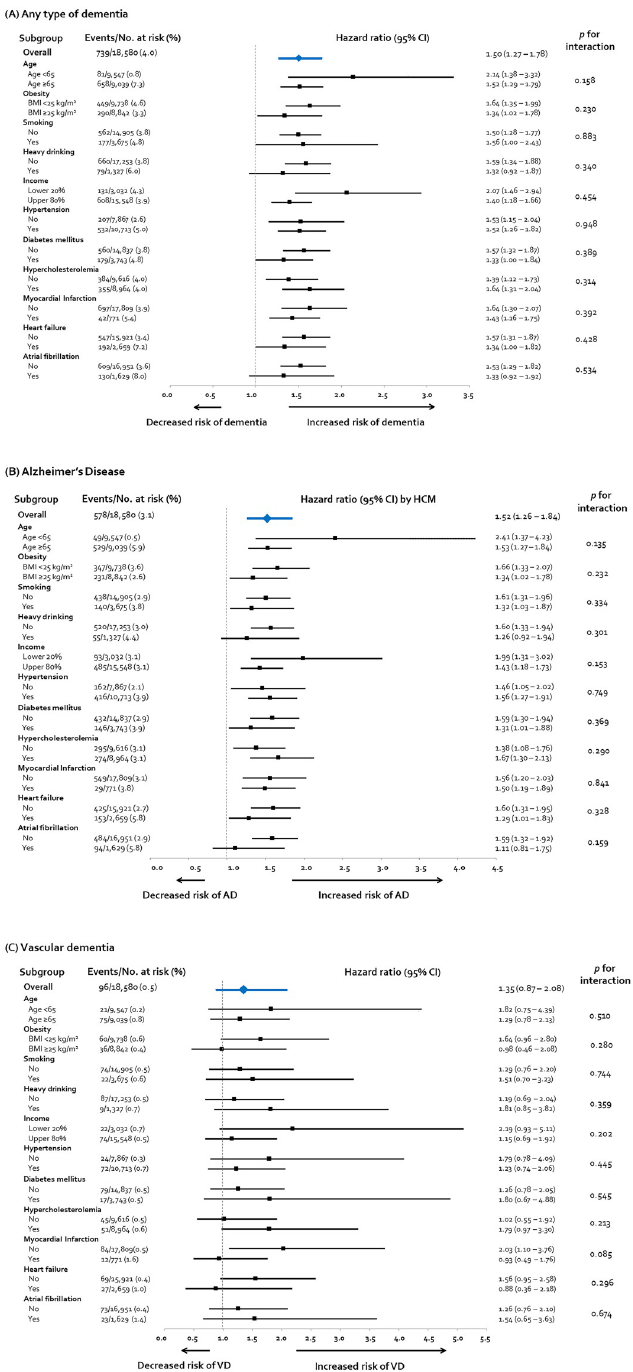
Fig 4. Subgroup analysis regarding the risk of AD by HCM. HCM showed a consistent tendency to increase the risk of any type of dementia (A) and AD (B), in almost all subgroups stratified by age, life behavior, and comorbidity. In particular, subgroups that were deemed low risk for dementia demonstrated a high risk for developing AD by HCM, suggesting the direct impact of HCM on cognitive dysfunction. On the other hand, the risk of VaD did not show a significant increase in all subgroups except for the subgroup without a history of MI. BMI, body mass index; CI, confidence interval; other abbreviations as Figs 1 and 2.